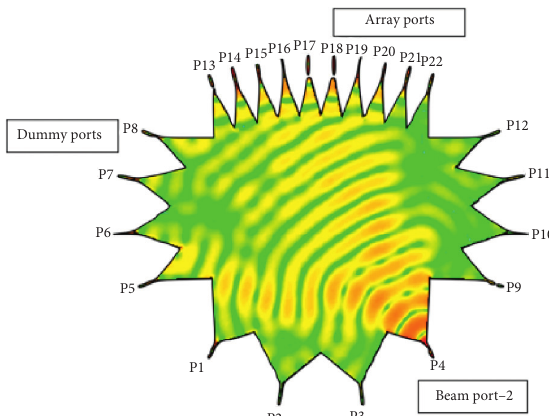
Figure 13: C-band Rotman lens: current distribution with beam port − 2 feeded at f